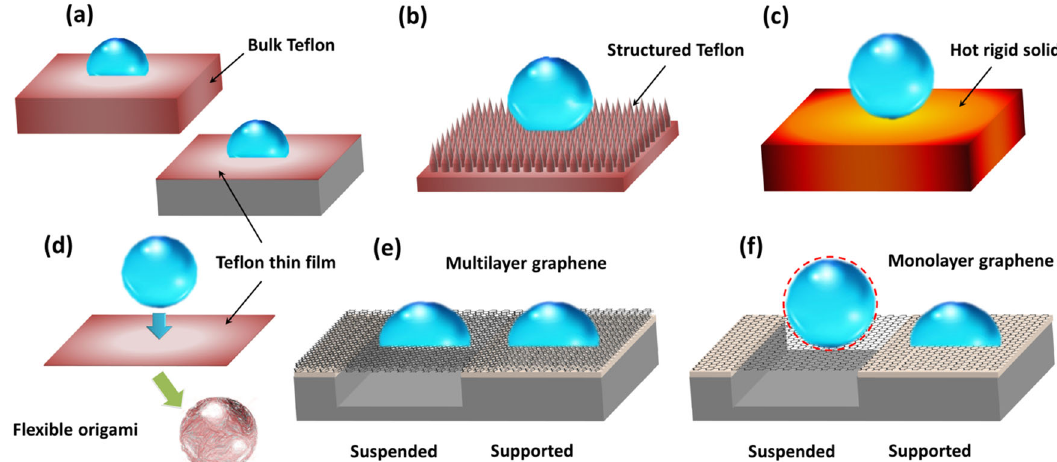
Fig. 1 Schematic representation of wetting and non-wetting of liquids on various materials. a Non-wetting on bulk rigid Te fl on ™ and on surface coated with a thin fi lm of Te fl on ™ , b non-wetting on superhydrophobic structured Te fl on ™ bed of nails, c non-wetting on a very hot rigid material, d wetting of hydrophobic Te fl on ™ thin fi lm wrapping itself around the droplet as in Capillary Origami 20 , e wetting on suspended and on supported multilayer graphene, and f wetting on supported monolayer graphene and non-wetting on suspended monolayer graphene where non-wetting droplet is highlighted by a red dashed